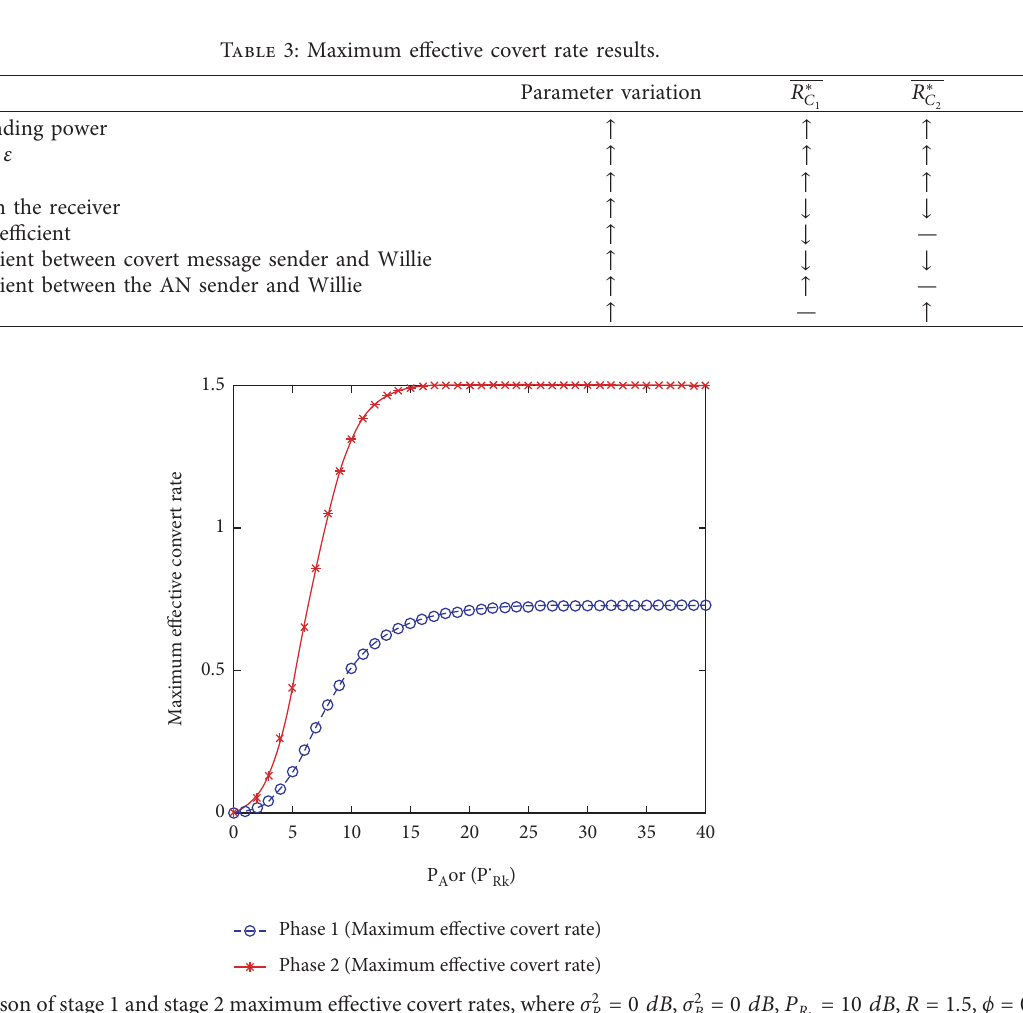
| 2 � 1, and h R j W